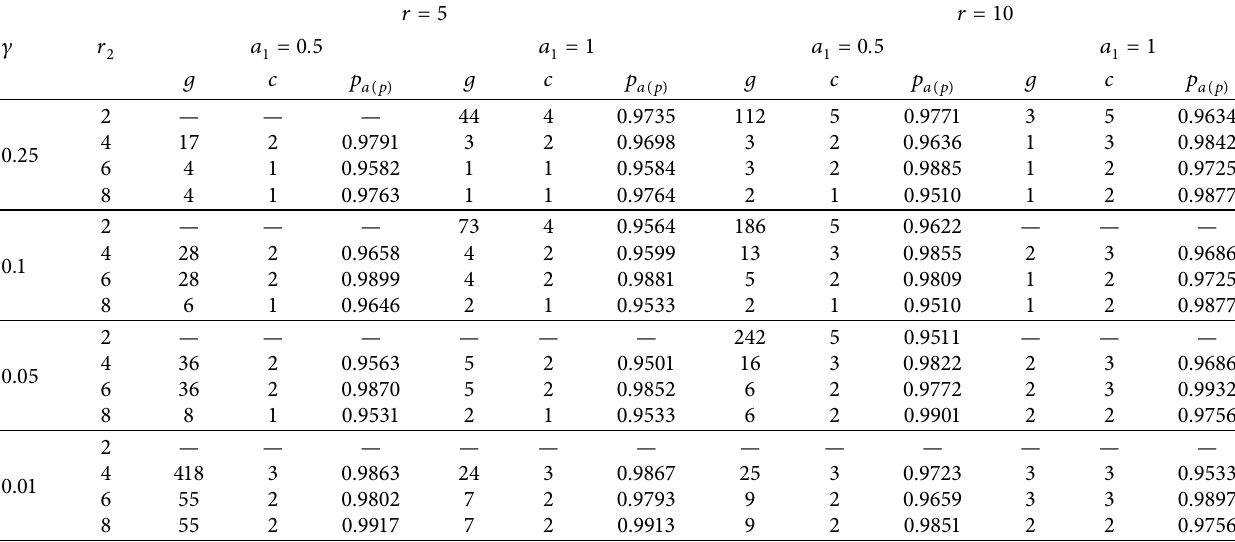
Table 1: GASP under the OPE model, showing minimum g and c when β � 1 and θ � 1 . 25.